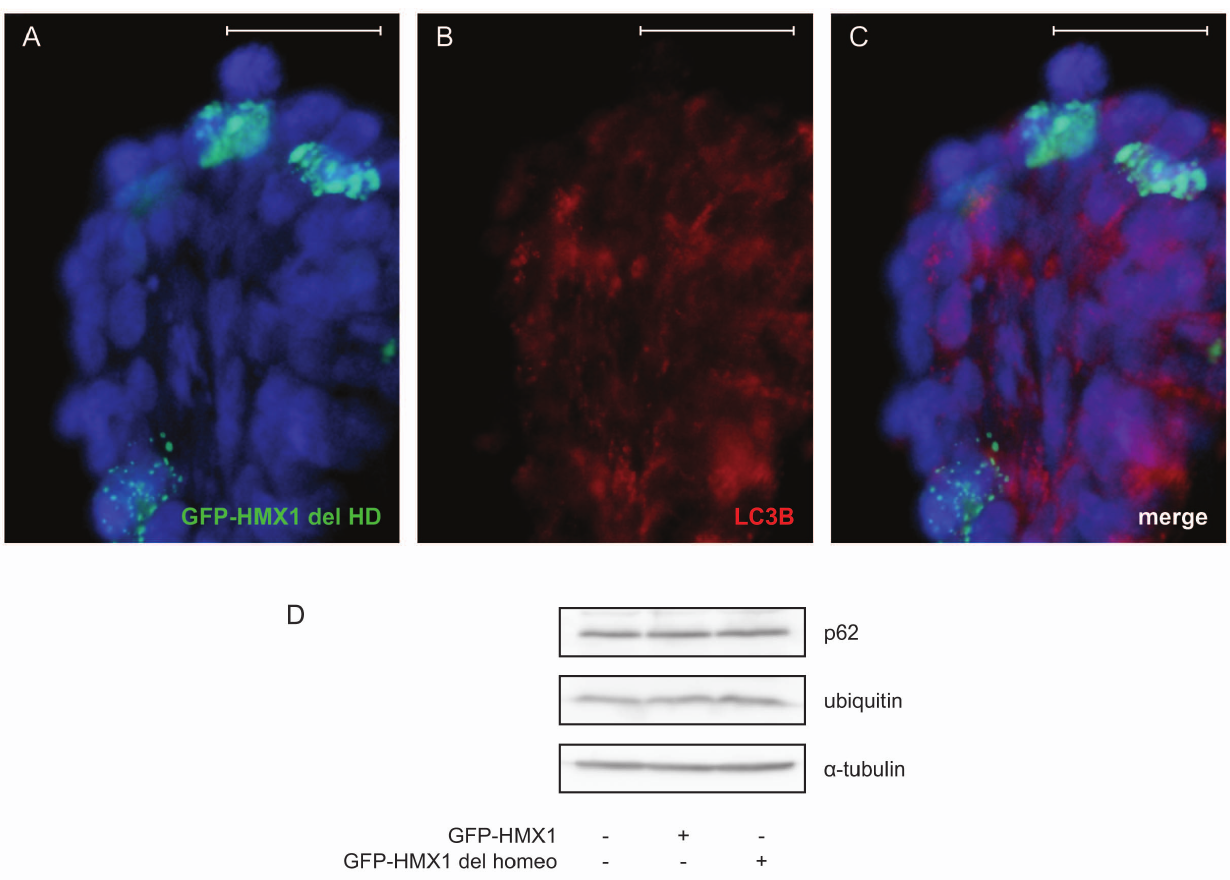
Figure 4. Determination of the nature of the GFP-HMX1 del HD aggregates. GFP-HMX1 del HD aggregates do not colocalize with LC3B and are thus not included in autophagosomes (A–C). Cells expressing GFP-HMX1 del HD (green) present no increased autophagy, and HMX1 del HD aggregates do not colocalize with autophagosomes (LC3B staining in red, after 50 m M chloroquine treatment for 16 hrs). Likewise, p62 and ubiquitin levels were not increased, confirming that autophagy was not activated (D). Scale bars: 50 m m.